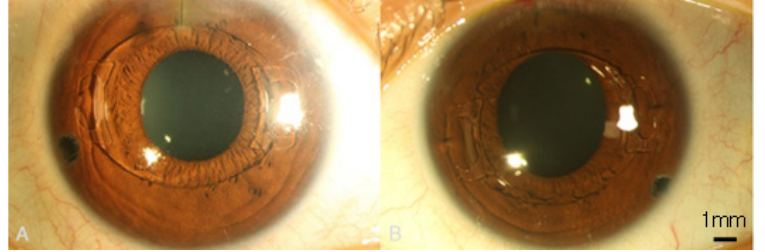
Figure 3. The clear cornea appearance with phakic intraocular lenses one week postoperatively. ( A ) The external eye image of right eye. ( B ) The external eye image of left eye.